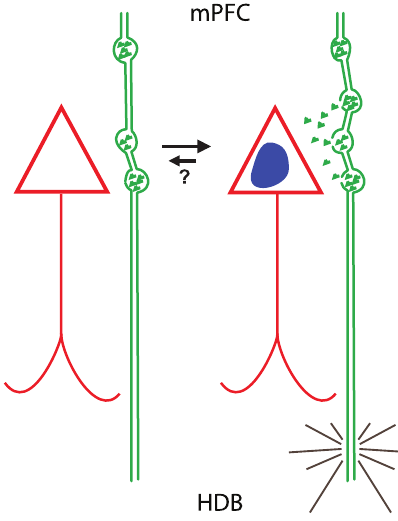
Figure 5. Schematic illustration of hypothetic duplication of the enpassant varicosities due to repetitive neuronal activa- tion. Repetitive activation (grey lines) of the cholinergic neurons in HDB could lead to induction of c-Fos (blue core) activation of pyramidal cells (red triangle) in mPFC and duplication of the cholinergic varicosities on their projecting fibers in vicinity of activated pyramidal cells. Whether this gain of varicosities is reversible remains to be determined (question mark). Abbreviations: HDB: horizontal limb of the diagonal band; mPFC: medial prefrontal cortex.